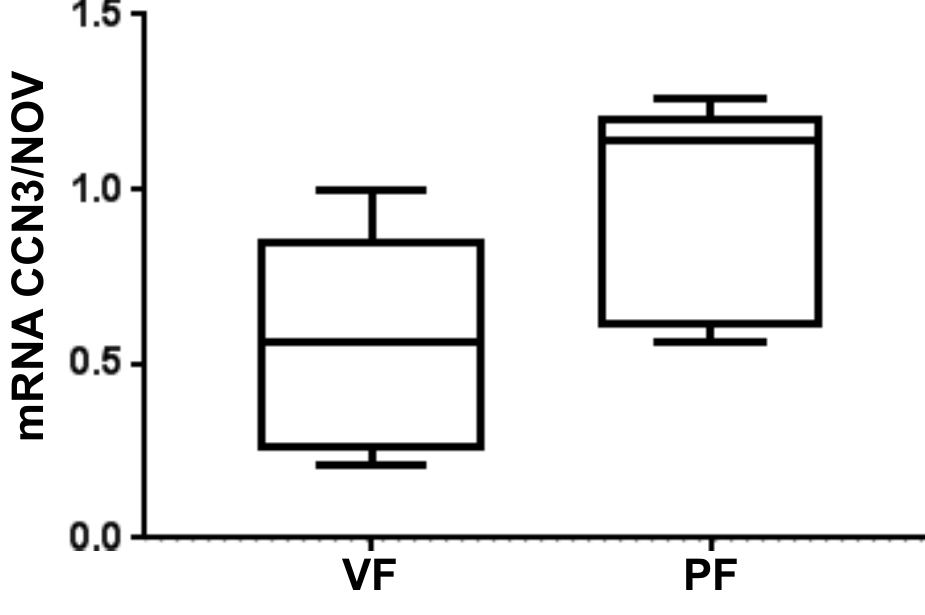
Figure 9. NOV mRNA expression in pericardial fat vs. visceral fat. NOV expression is increased in pericardial